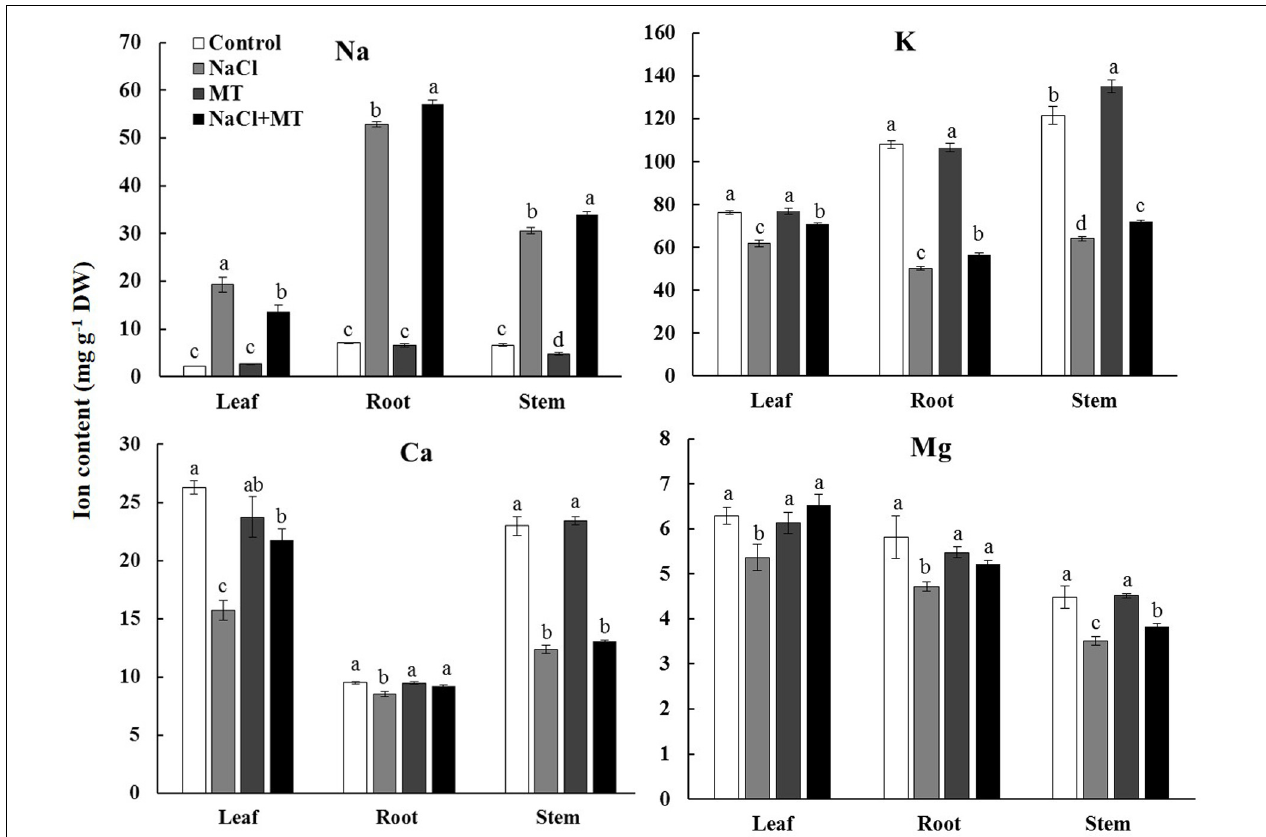
FIGURE 1 | Effects of MT on the K + , Na + , Ca 2 + , and Mg 2 + contents in NaCl-stressed or non-stressed Xu 32. Xu 32 seedlings were pretreated with 0.5 µ M (root) + 100 µ M (leaf) MT for 3 days before being subjected to the 150 mM NaCl stress. K + , Na + , Ca 2 + , and Mg 2 + contents were analyzed after 7 days of salinity treatment. Columns represent the means of independent measurements of five individual plants per treatment, and bars represent the standard error of the mean. Columns labeled with different letters indicate significant difference at P <